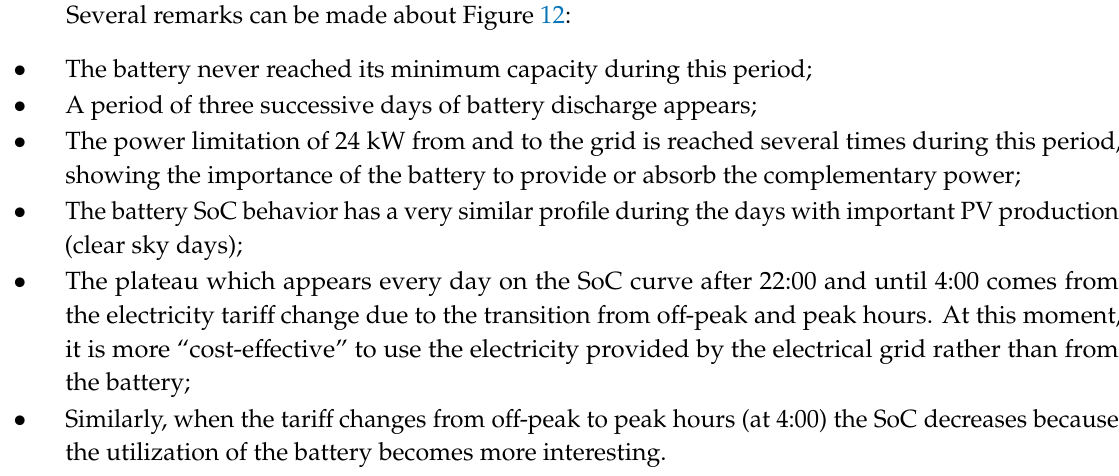
Figure 12. Linear programing optimization (LP) optimization Figure 12. linear programing optimization (LP) optimization (reference).